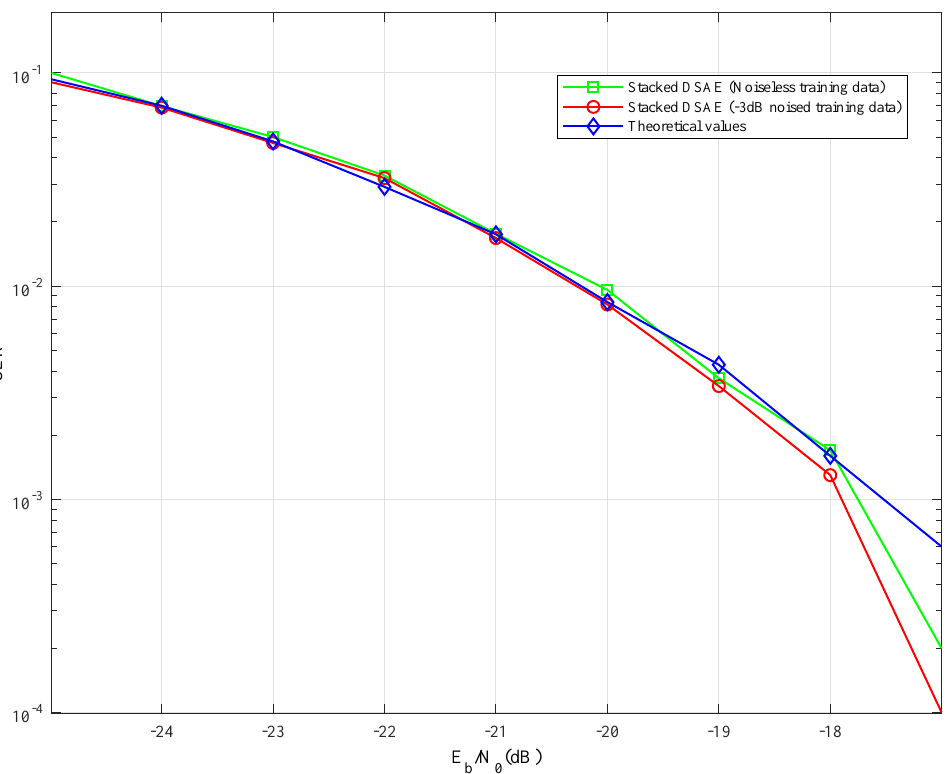
Figure 5. SER of the stacked DSAE network for the improved 2PPSK